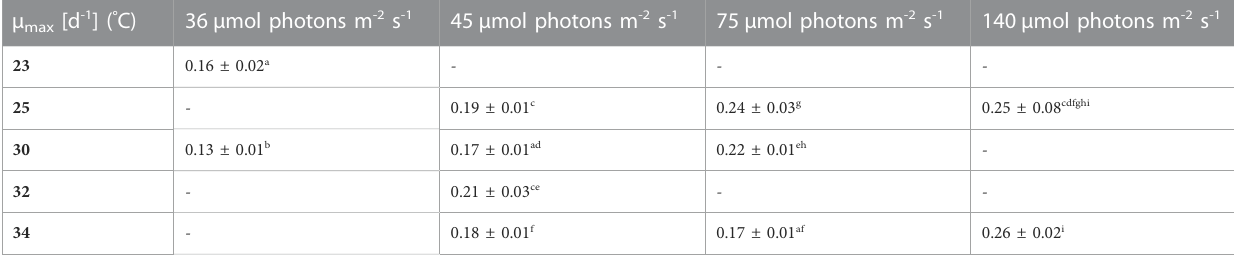
TABLE 1 Overview of the maximum speci fi c growth rates (µ max ) for biomass concentration X (DW) in the different growth conditions. The maximum growth rate re fl ects only the fi rst 3 – 4 days of growth, where an exponential growth was shown by using a logarithmic scale and linear regression, the values are shown as mean ± CI(95%) of four to eight cultures. Different letters (a-l) indicate signi fi cant differences ( p < 0,05).